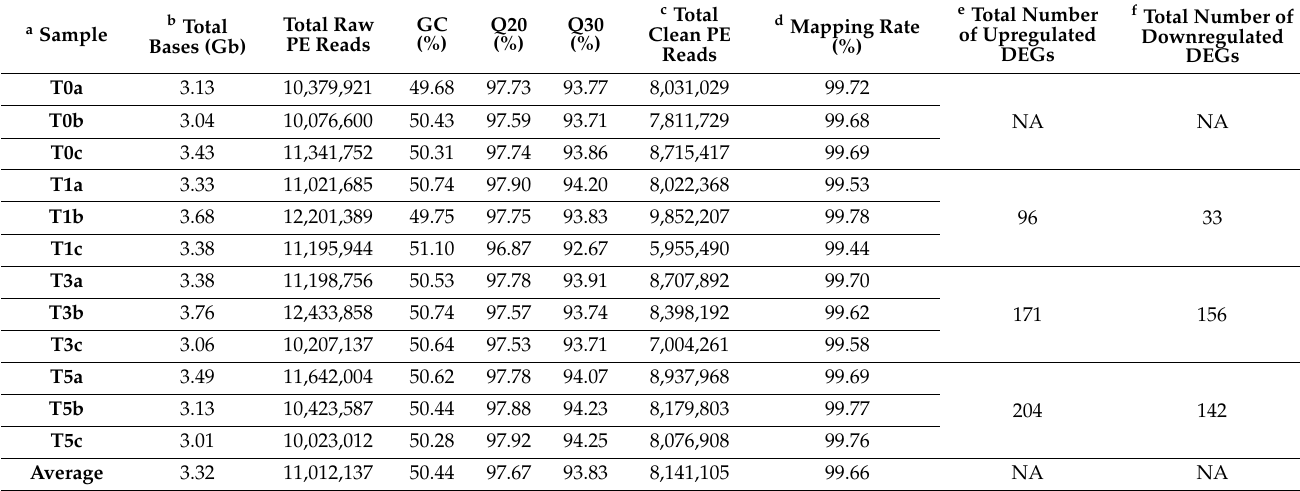
Table 1. Summary of RNA sequencing data.